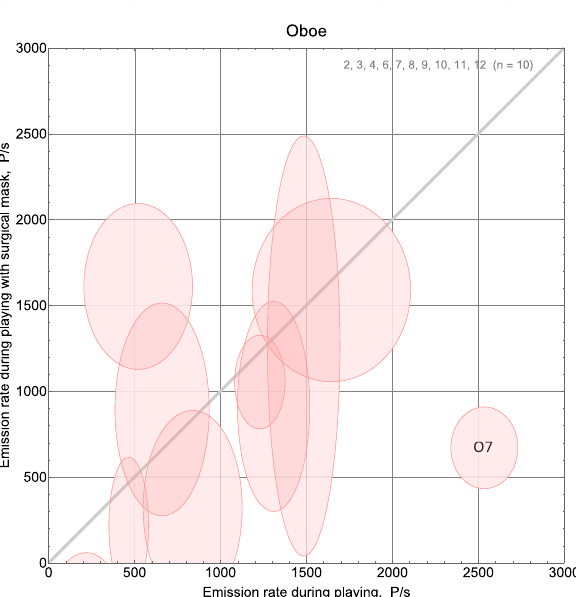
Figure 5. Aerosol emission rates (unit: particles/s) are displayed for the tasks wind instrument playing ( a ) flute, ( b ) oboe, and speaking. The centre point of the ellipse indicates the emission rate from instrument playing on the ordinate and from speaking on the abscissa. The semiaxes of the ellipse indicate the standard deviations of estimation uncertainty for each task, according to bootstrap calculation. The grey lines indicate equal emission rates during both tasks. Ellipses above that line indicate higher emission rates from wind instrument playing than from speaking. The ellipses indicate credibility regions, opacity indicates likelihood.